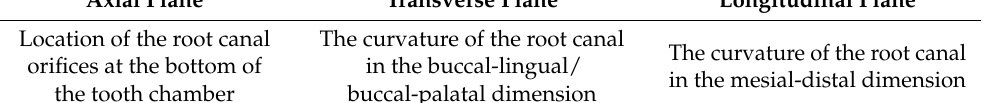
Figure 1. The CT scan of a tooth with a pantographic curve, with the blue line marking the angle and perspective for the front view, can be generated separately. The red line marks the pantographic curve. Table 1. Parameters of the patient’s tooth condition are assessed based on cone beam computed tomography.